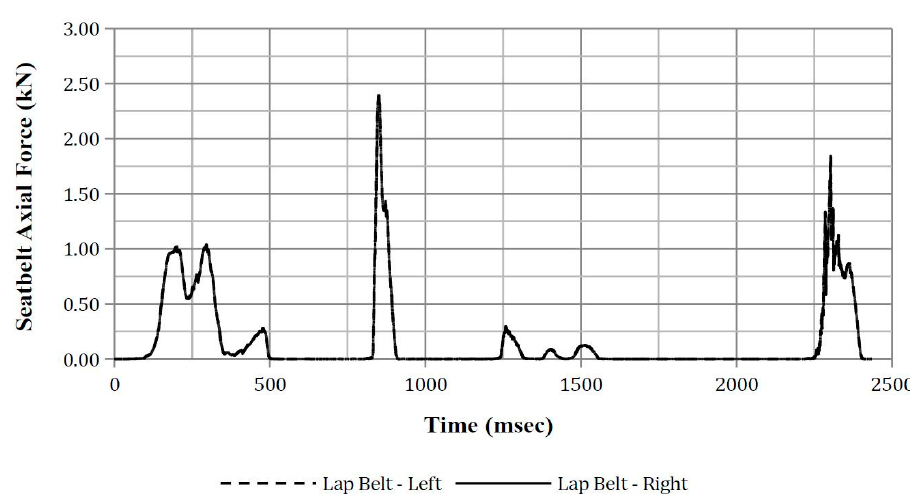
Figure A36. ATD Position 8 lap belt axial force.